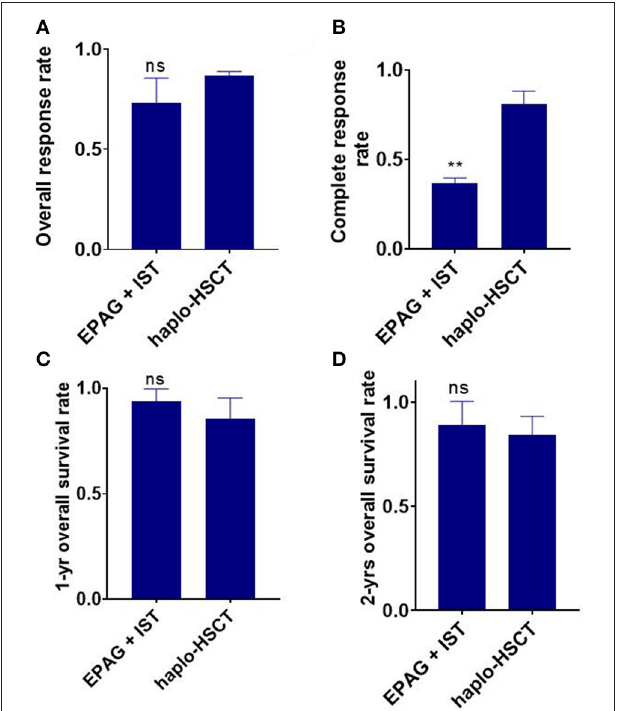
FIGURE 2 | Indirect comparison the overall response rate (ORR), complete response rate (CR), 1-/2-year overall survival (OS) between EPAG + IST and haplo-HSCT group. (A) Bar plot shows similar ORR between the two groups. ns, p > 0.05, based on the Student t -test. (B) Bar plot shows significantly lower CR rate in the EPAG + IST group compared with the haplo-HSCT group. ** p < 0.01, based on the Student t -test. (C,D) Bar plots show that the 1-/2-year OS was similar between the indicated groups. ns, p > 0.05, based on the Student t -test. EPAG, eltrombopag; IST, immunosuppressive therapy; haplo-HSCT, haploidentical hematopoietic stem cell transplantation.